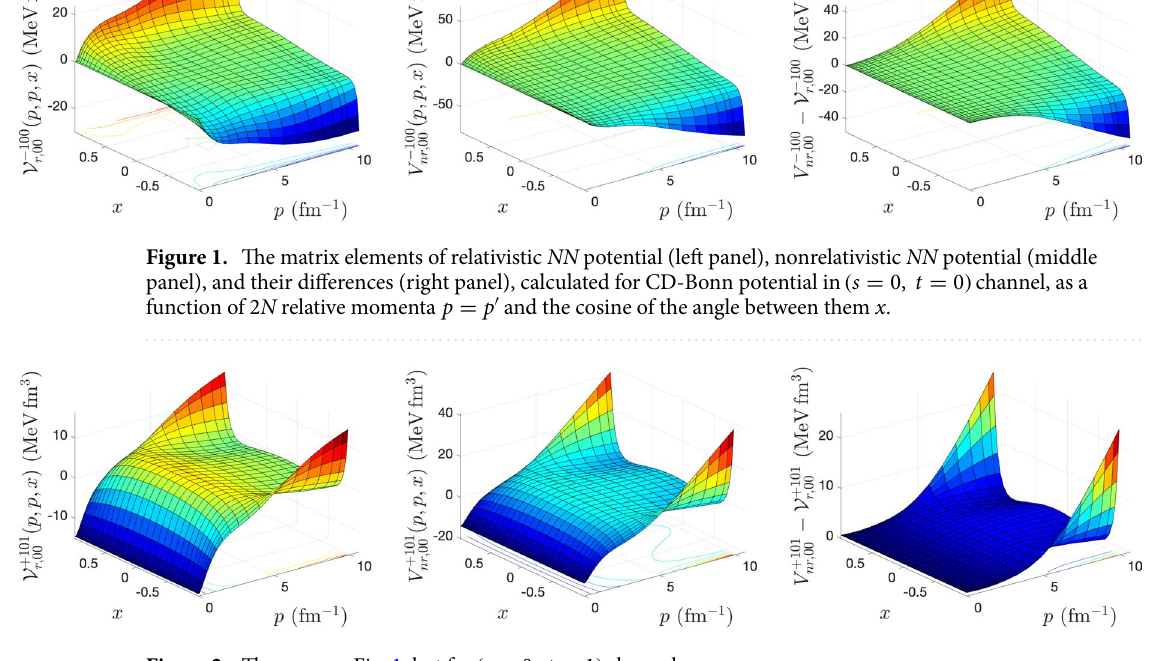
0, t 0 ) channel, as a = =